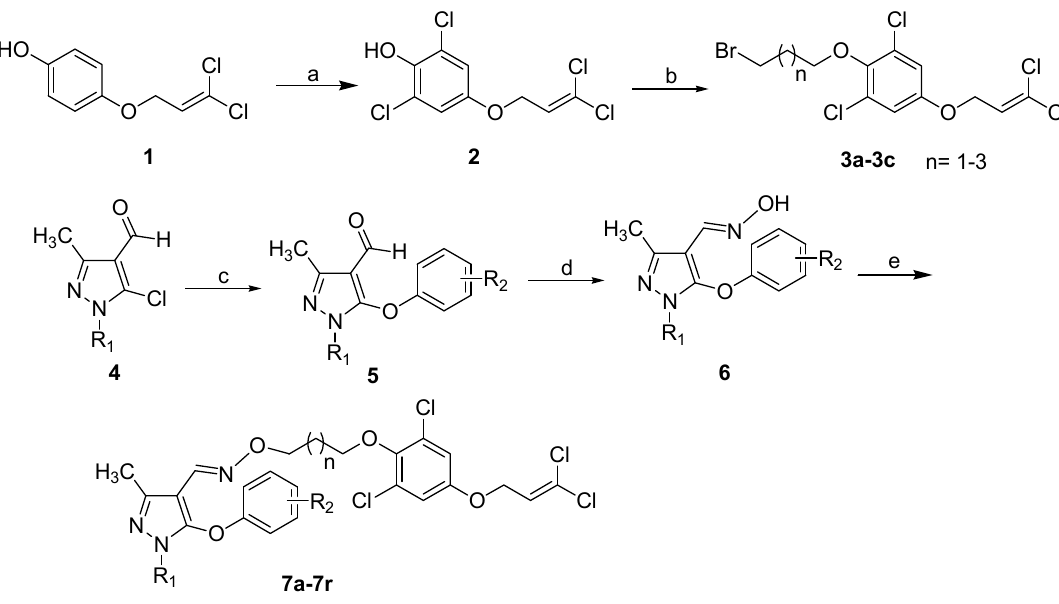
Scheme 1. Synthesis of the title compounds 7a – 7r . Reagents and conditions: (a) sulfonyl chloride,